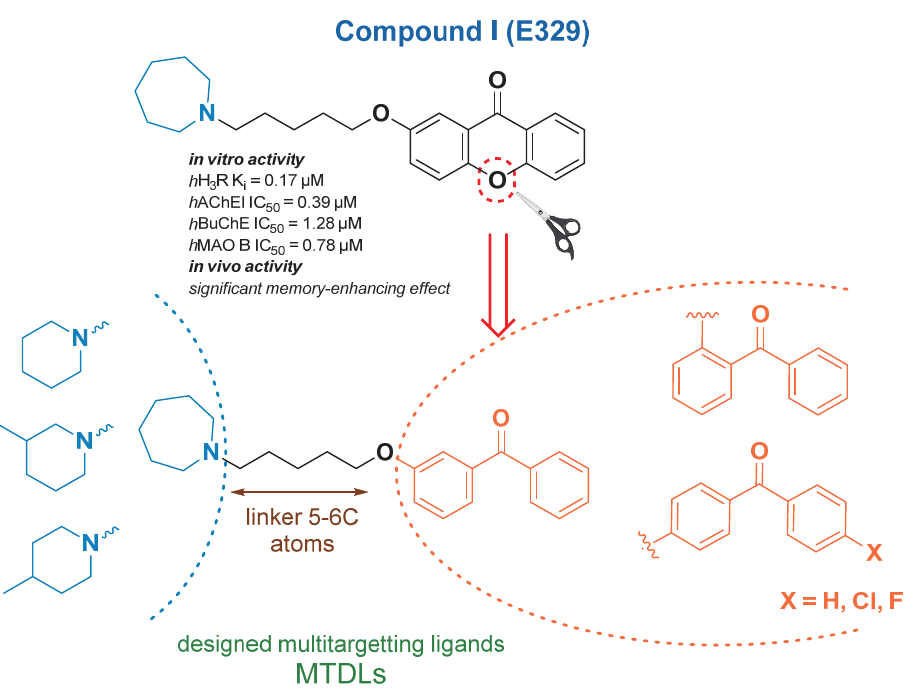
Figure 1. The general structures of the novel compounds designed as H 3 R/ChE/MAO B MTDLs, based on previously obtained [32] promising lead I .